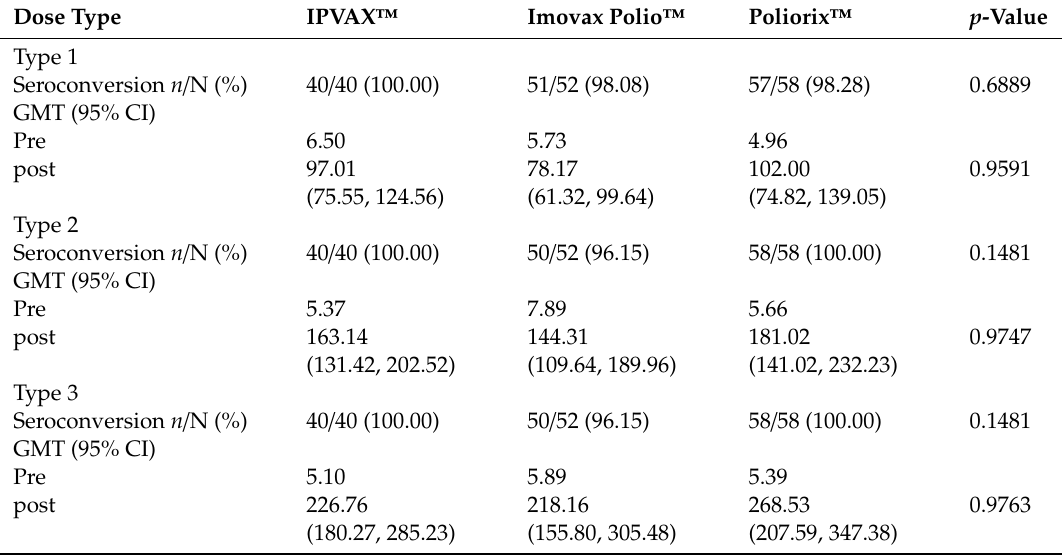
Table 2. Seroconversion rates and neutralizing antibody titers after primary enhanced-potency inactivated poliovirus vaccine (eIPV)